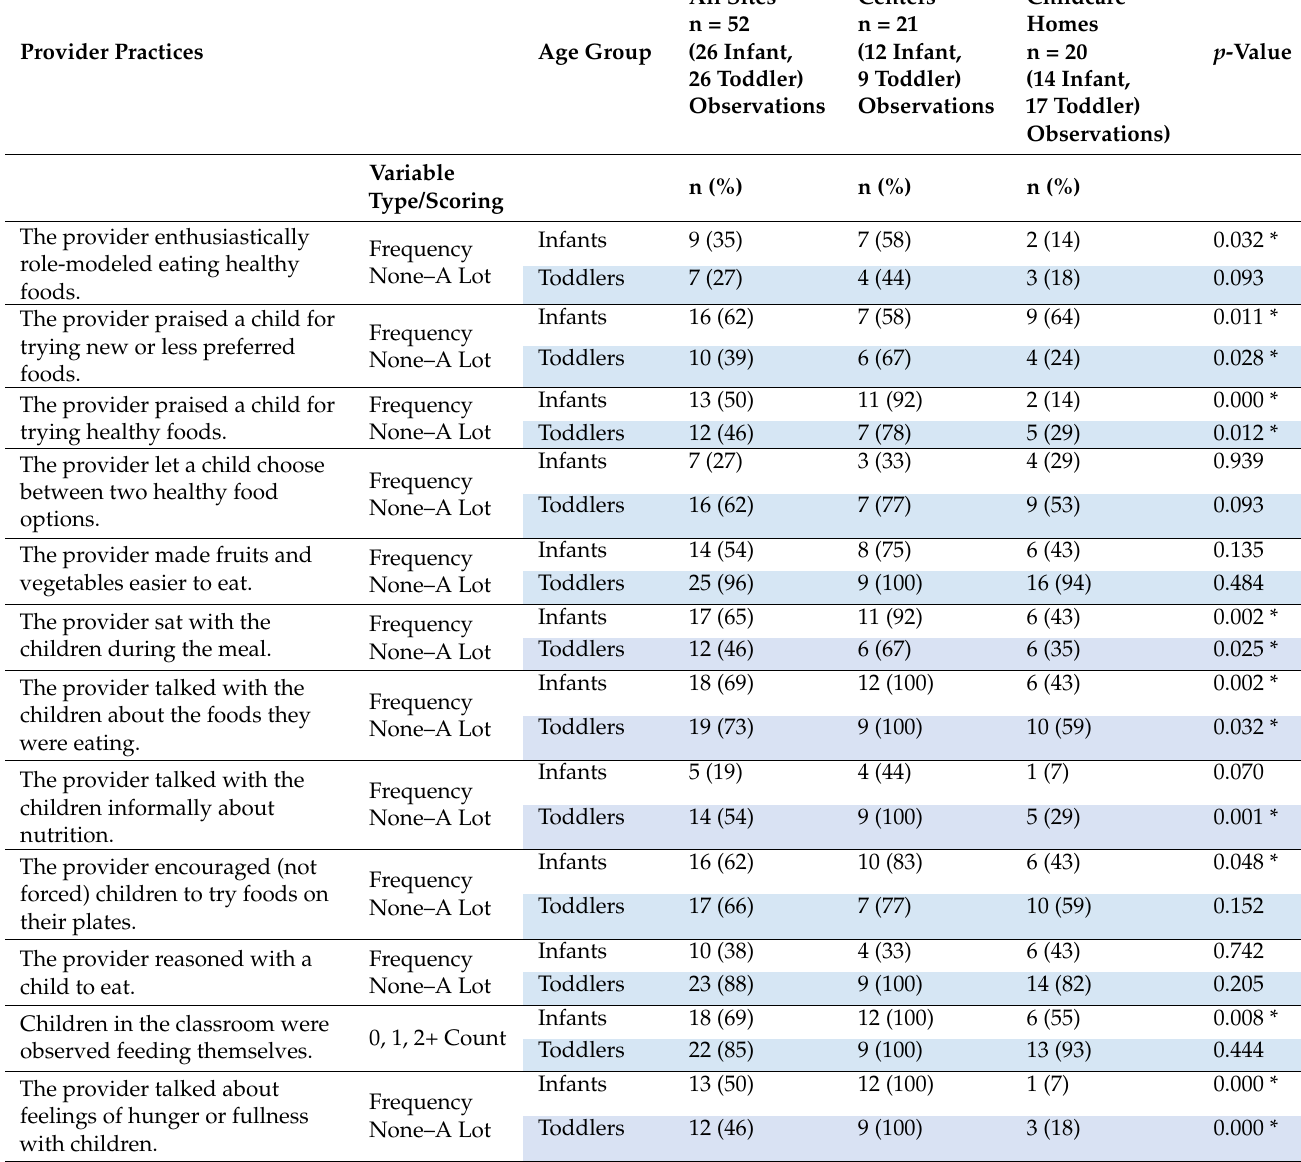
Table 2. Frequency of Recommended Feeding Best Practices and Provider–Child Interactions in Centers and Family Childcare